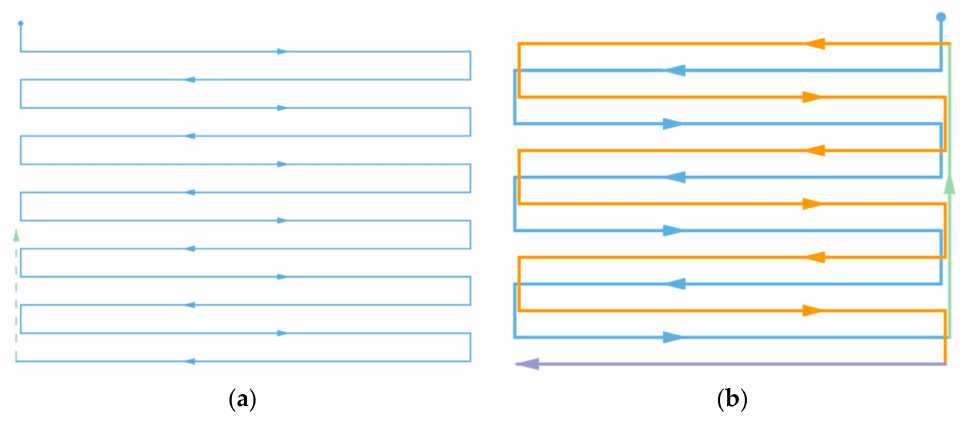
Figure 5. ( a ) Conventional Boustrophedon path and ( b ) the proposed cycle-Boustrophedon